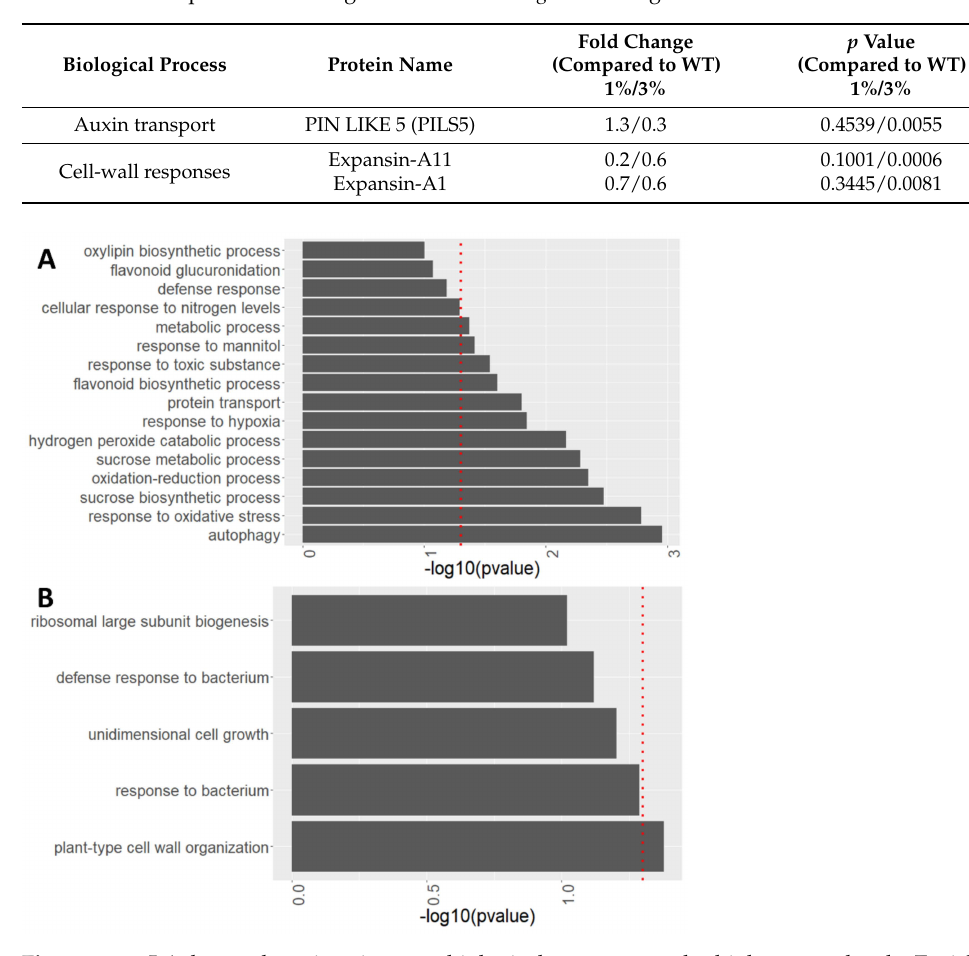
Figure 7. atg5-1 shows alterations in many biological processes under high sucrose levels. Enriched biological processes identified from proteomics analyses performed using David functional anno- tation tools in GOTERM_BP_DIRECT. ( A ) Biological processes involving protein accumulation in atg5-1 compared to WT under 3% sucrose. ( B ) Biological processes involving protein depletion in atg5-1 compared to WT under 3% sucrose. The red dotted line indicates the threshold for significant enrichment of the given proteins for the biological process ( p <